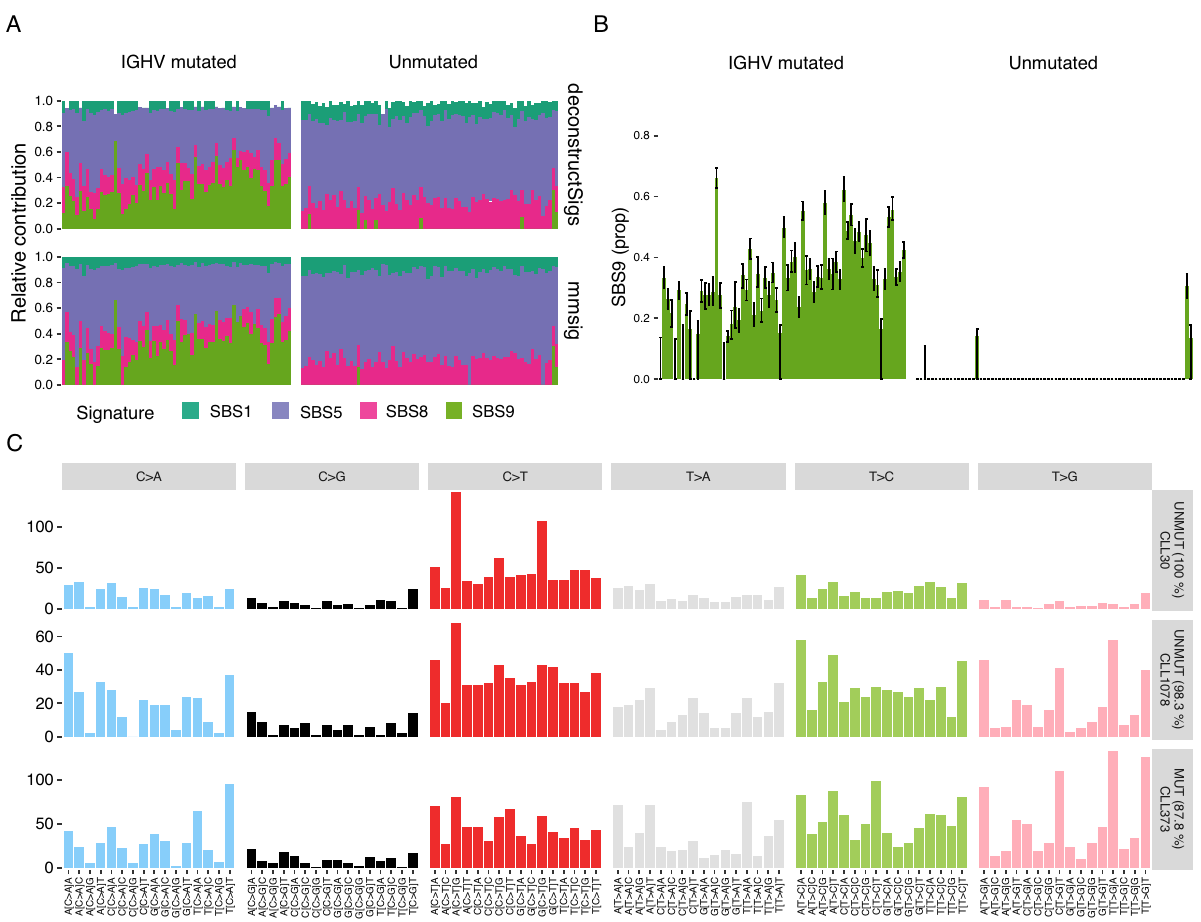
Fig. 5 Identifying non-canonical AID-induced mutagenesis in chronic lymphocytic leukemia. A Mutational signature pro fi les of 142 patients with chronic lymphocytic leukemia (CLL) with mutated ( n = 68, left) or unmutated ( n = 74, right) IGHV gene, estimated using deconstructSigs (top) and mmsig (bottom). B Bar chart showing the estimated proportion of mutations caused by non-canonical AID (nc-AID; SBS9) with 95% CI generated by 1000 bootstrapping iterations. C 96-class mutational pro fi les of three patients from top to bottom: unmutated CLL without evidence of nc-AID activity; unmutated CLL based on IGHV identity (<2% mutations), but evidence of genome-wide nc-AID activity; CLL with highly mutated IGHV as well as strong nc-AID signature